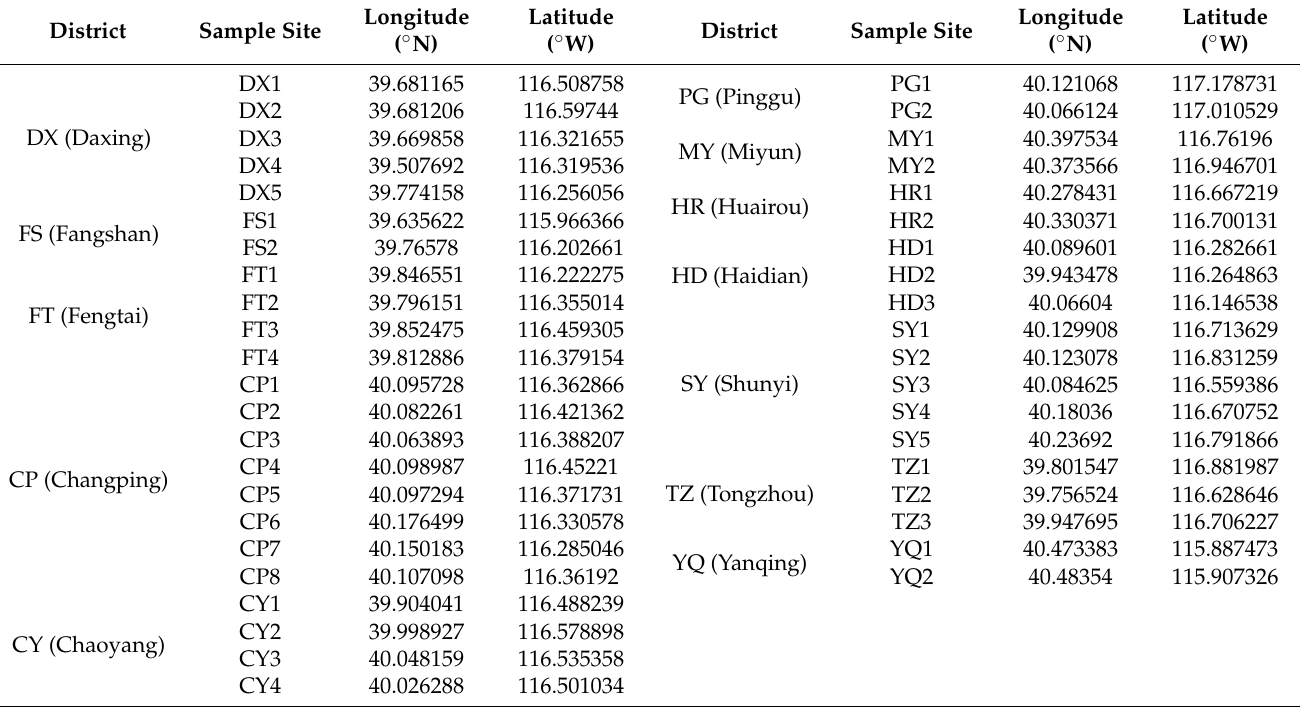
Figure 1. Plain afforestation research plot. HR (Huairou District), YQ (Yanqing District), MY (Miyun District), PG (Pinggu District), CP (Changping District), SY (Shunyi District), HD (Haidian District), CY (Chaoyang District), TZ (Tongzhou District), FS (Fangshan District), FT (Fengtai District), and DX (Daxing District). Table 1. Basic information about the 42 selected sample